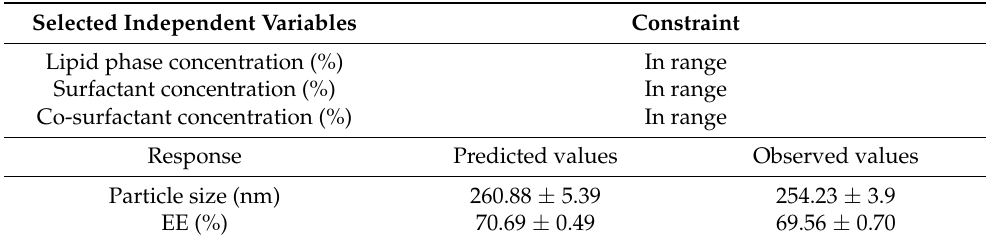
Table 4. Predicted and observed value for the optimized ATO-NLC